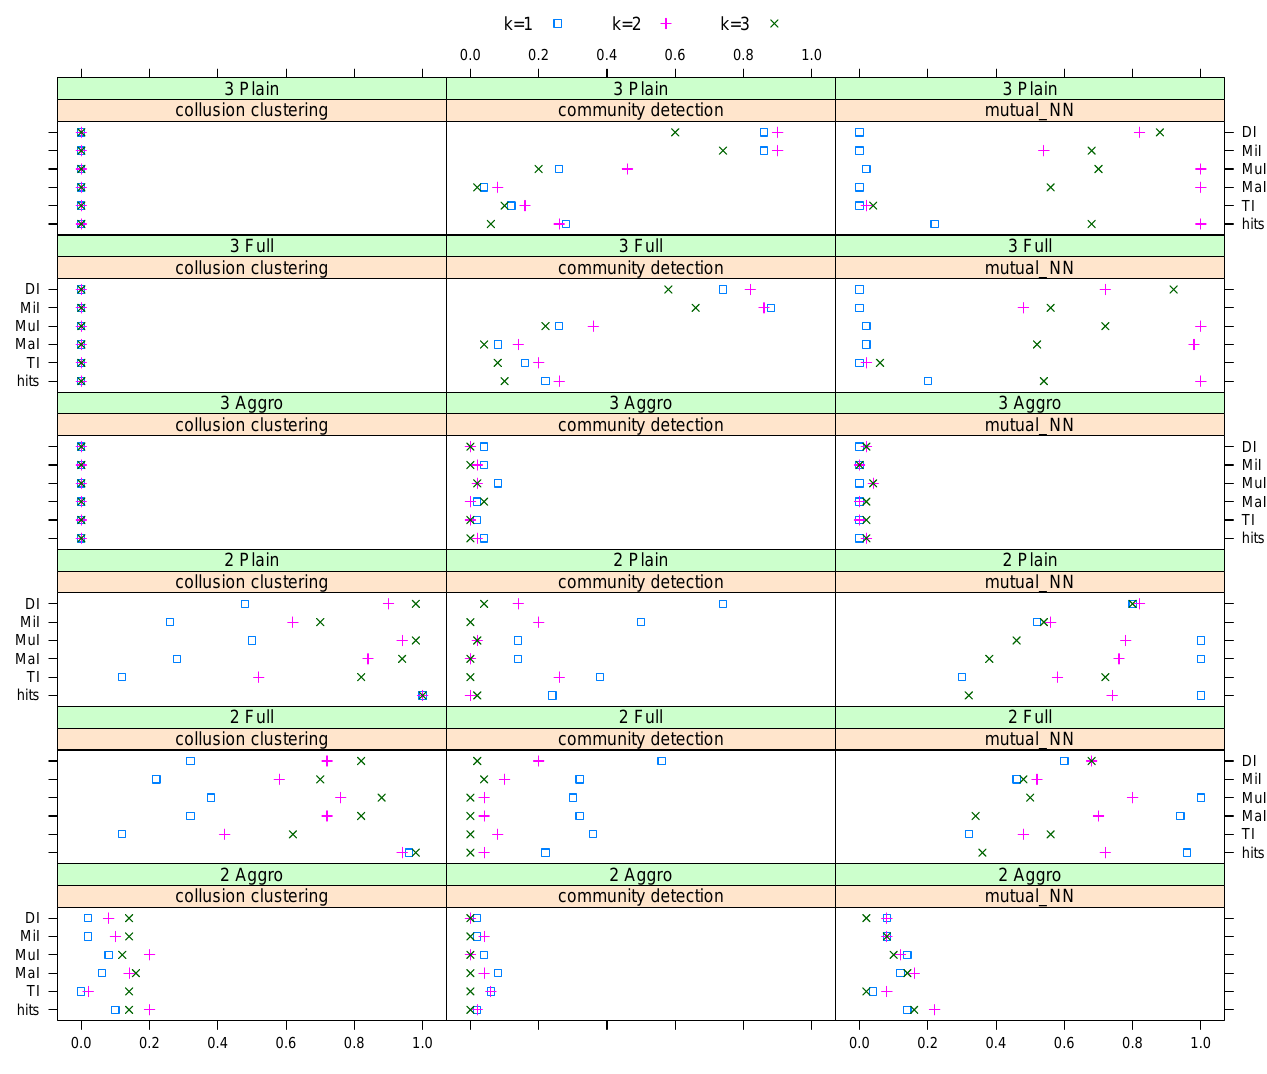
Fig. 2. The amount of colluding subsets found in 50 test games using different edge weights (vertical titles) and clustering algorithms (orange titles). Shared_NN has been omitted due to its poor performance. Games without colluders are not included.